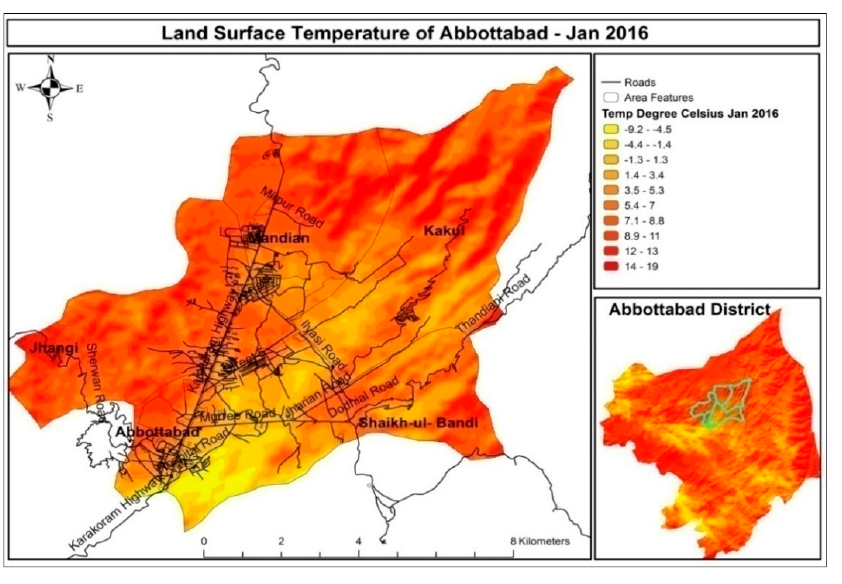
Figure 9. LST of Abbottabad—Jan 2011–2016.